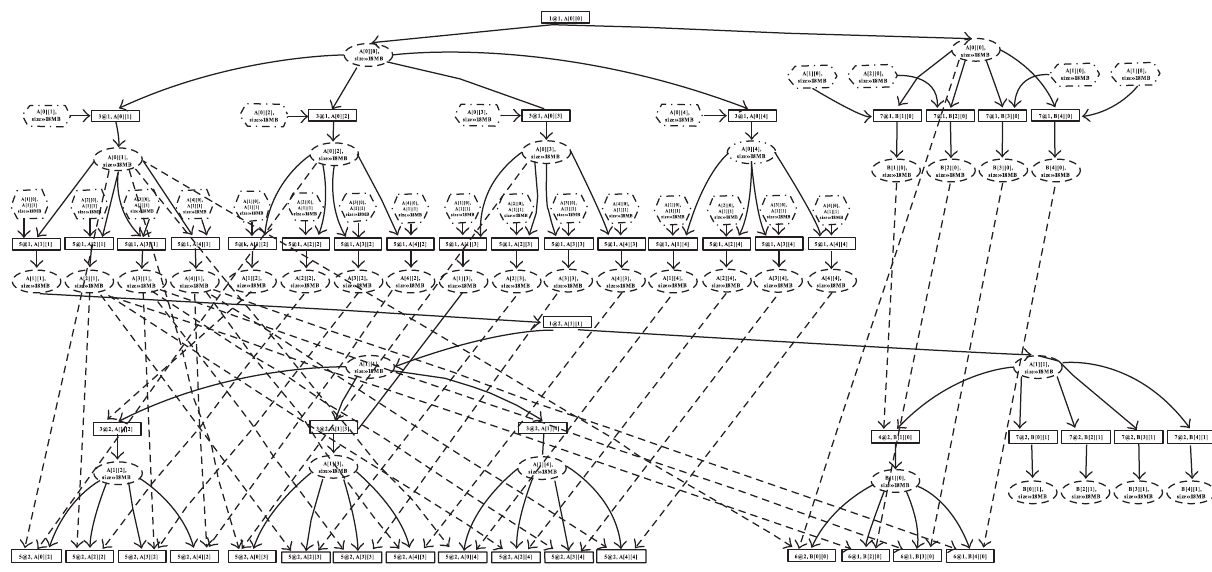
Figure 3: Data transfer model in BbGJ